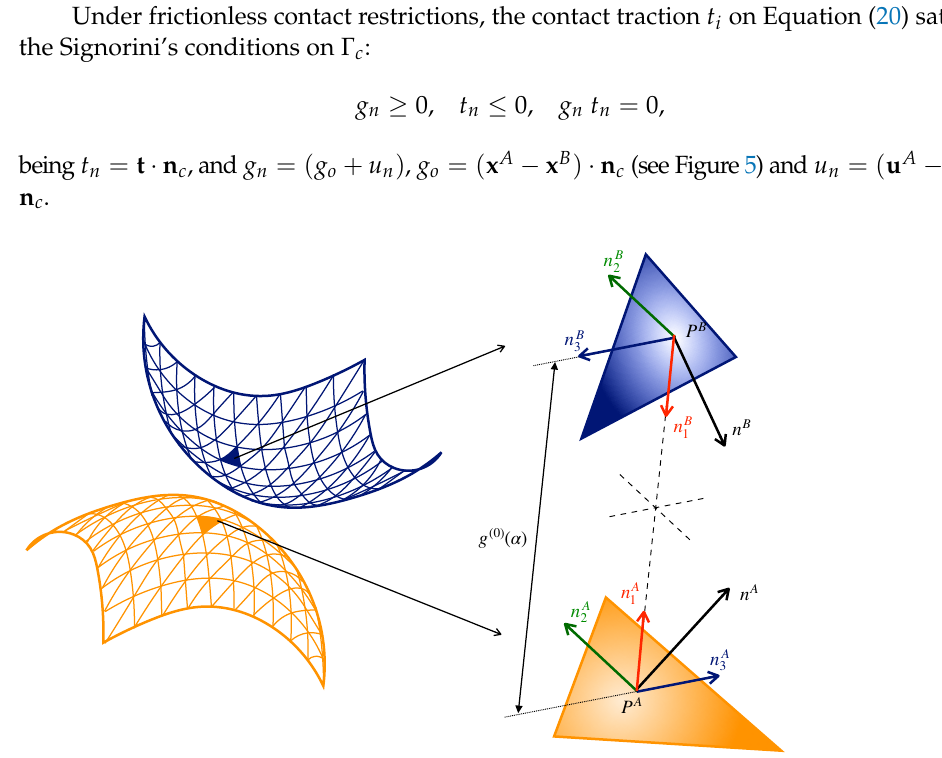
Figure 5. Local coordinate system of each pair of elements in